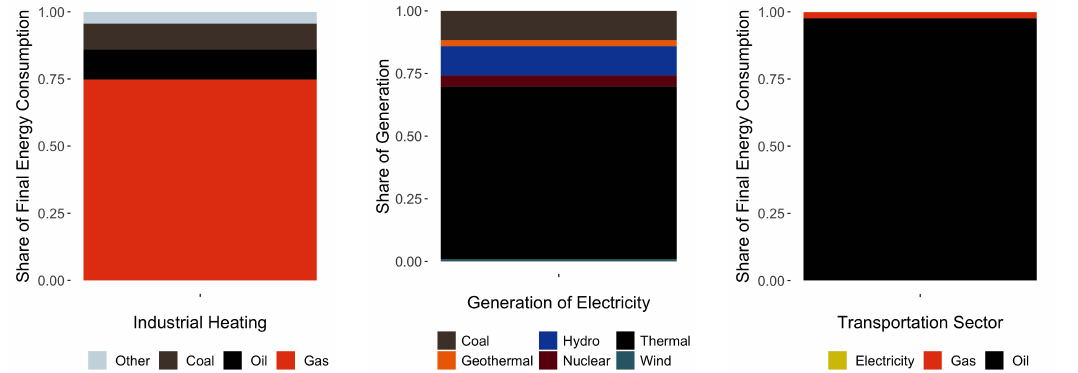
Figure 2. Fuel and Technology Composition of the Heating, Power and Transport Sectors.